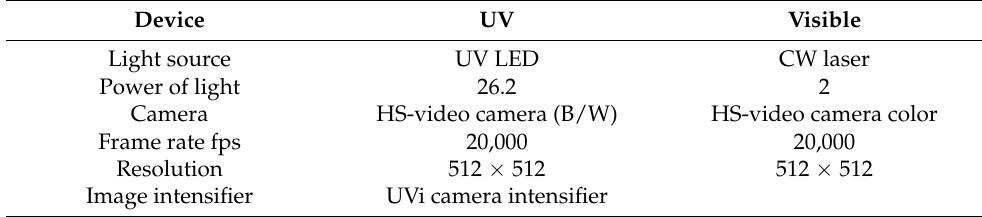
Table 1. Specification of light source and image